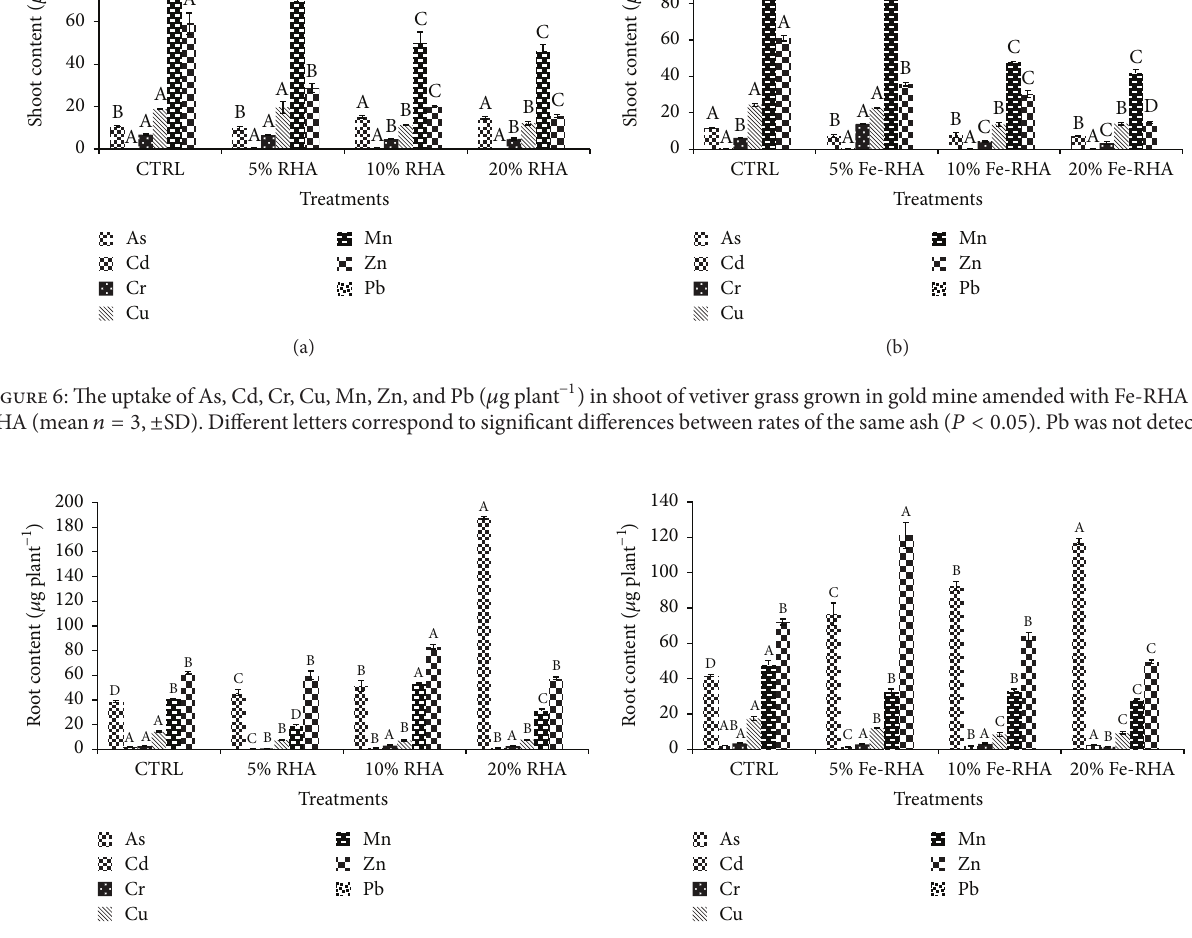
root decreased with increasing RHA rates compared to